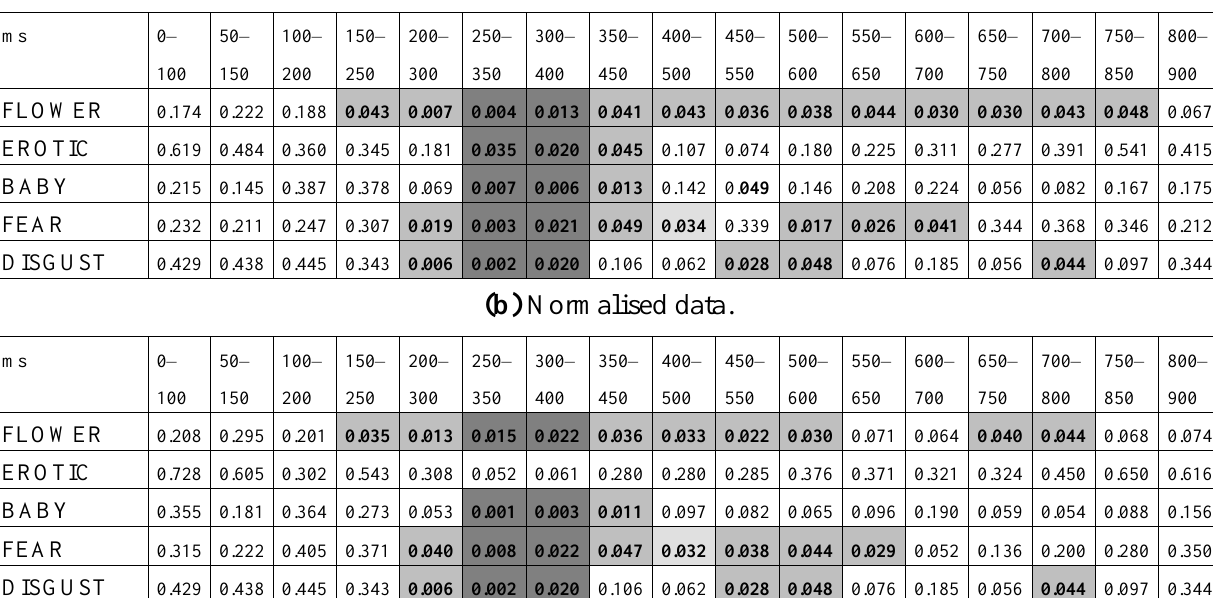
Table 2. Reapted measures ANOVA results of raw and normalised MEG data. Displayed are p-values after Greenhouse-Geisser correction for odor*hemisphere*sensor interaction with each picture category and for all time intervals. Note that between 250 ms and 400 ms after stimulus onset consistent effects occurred across picture categories (marked in dark grey). Other significant interactions are marked in light grey. (a) Raw